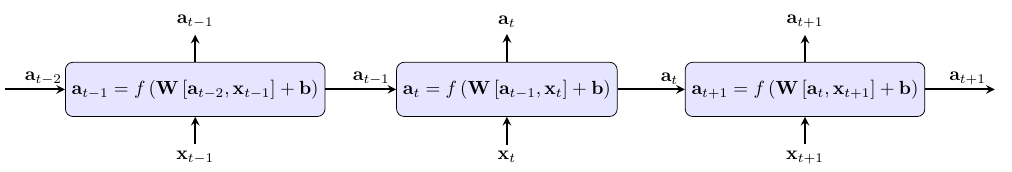
Figure 2. A standard fully-connected feedforward neural network ( a ) and a recurrent neural network ( b ). The recurrent neural network is extended by an additional loop.